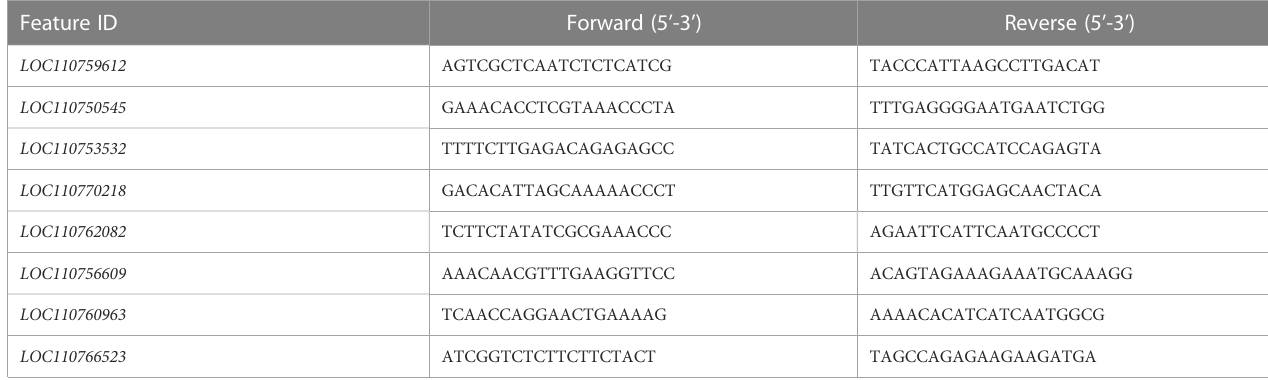
TABLE 1 Sequence of forward and reverse qRT-PCR primers by gene (feature ID).